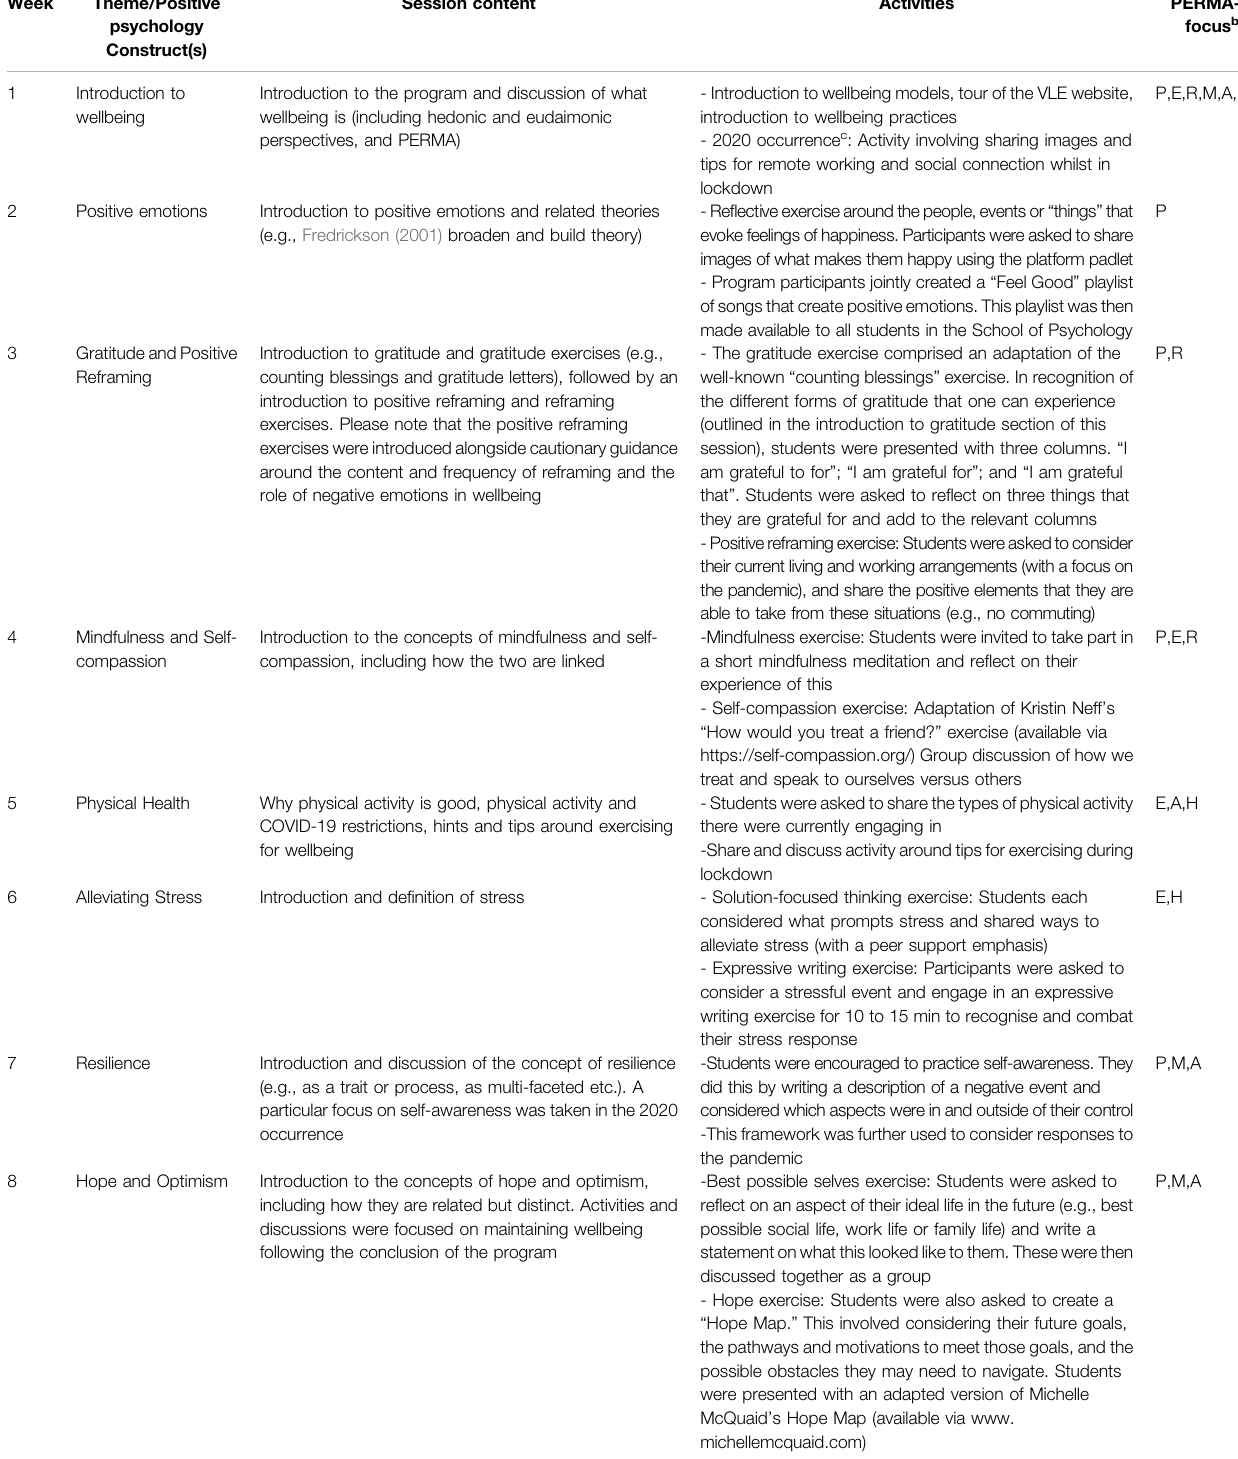
TABLE 1 | Overview of weekly wellbeing sessions, activities and PERMA-H focus a